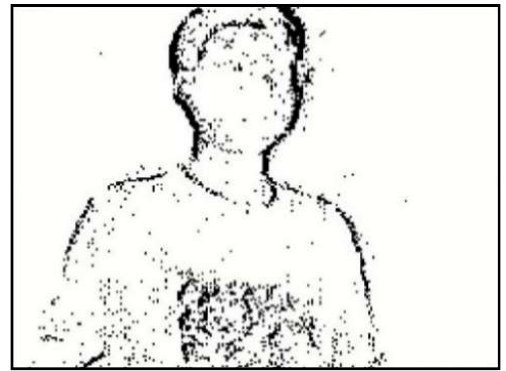
Figure 4. Event frame reconstruction.